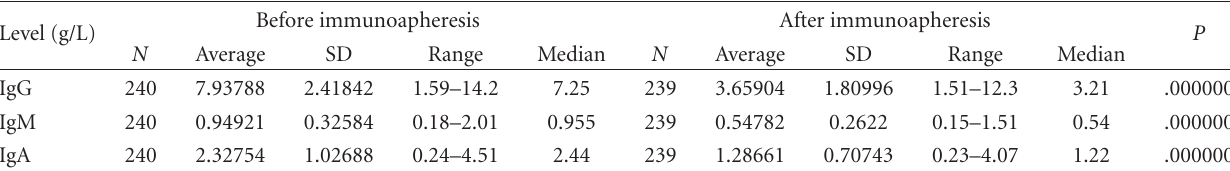
Table 3: Immunoglobulins. N : number of patients, SD: standard